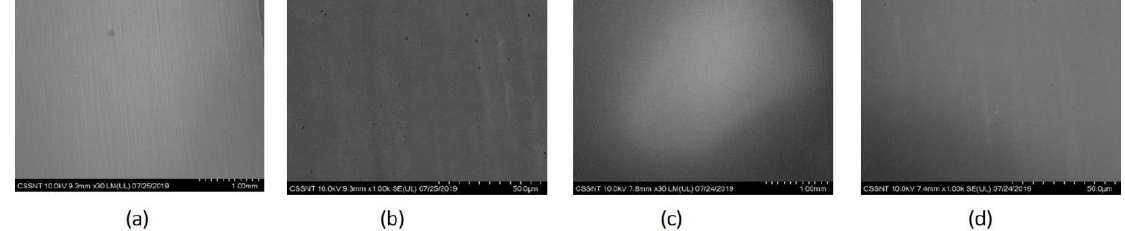
Figure 1. SEM micrographs for NiCr alloy ( a ) and ( b ) and for CoCr alloy ( c ) and ( d ) at two different magnifications (30 × and 1 kx).